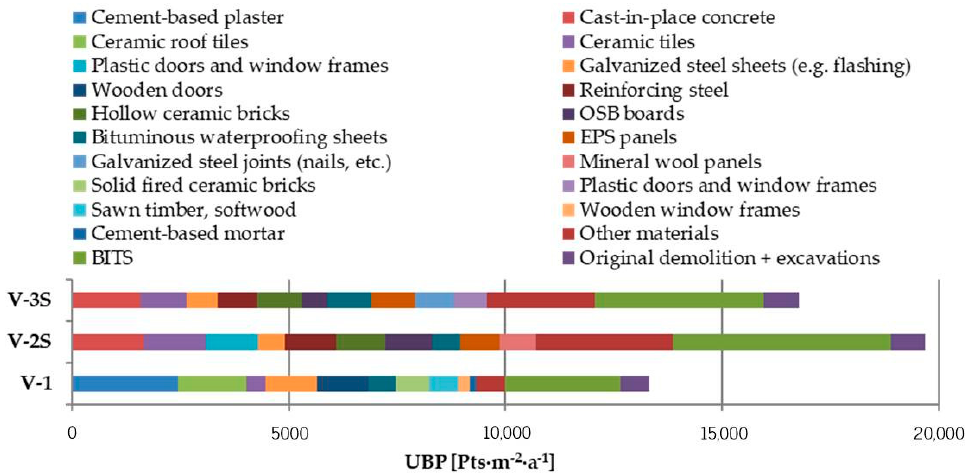
Figure 8. Shares of the ten most-demanding construction materials on the embodied environmental impacts (EEIs) of selected variants of the house.